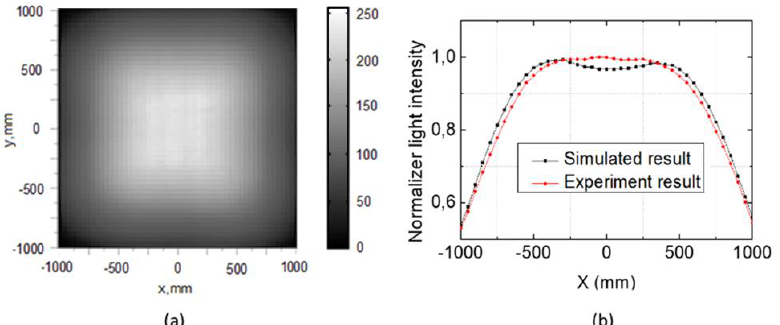
Figure 14. Experiment results of the distribution measuring system. ( a ) Distribution on the target surface. ( b ) Comparison of the simulation and experiment distribution along the X axis across the center of the target surface.